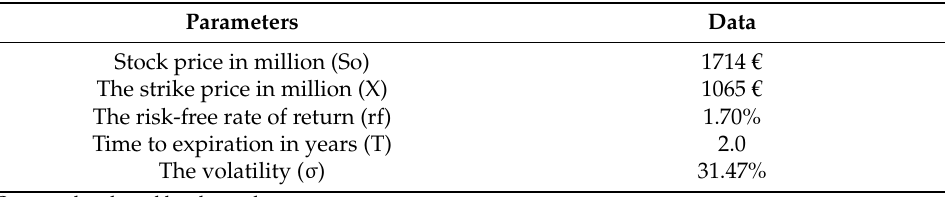
Table 4. Black–Scholes option-pricing model input variables.